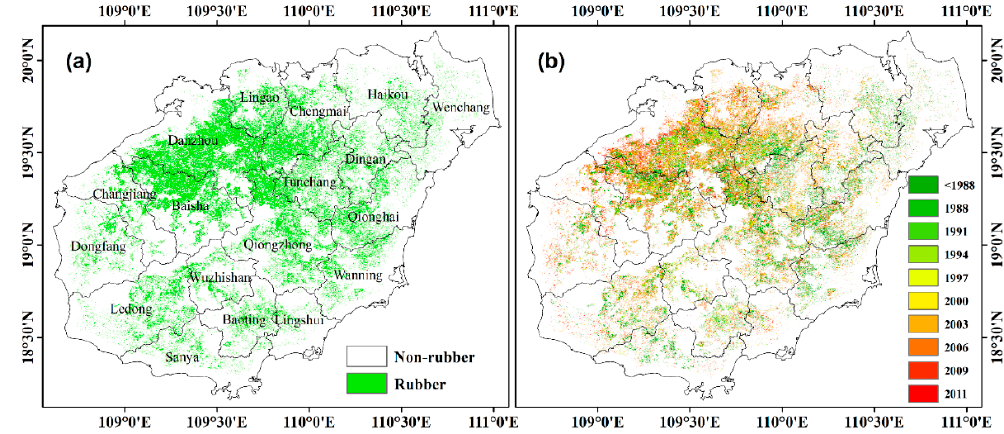
Figure 6 . Spatial distribution of ( a ) rubber plantations in 2015 and ( b ) their establishment year on Hainan Island.